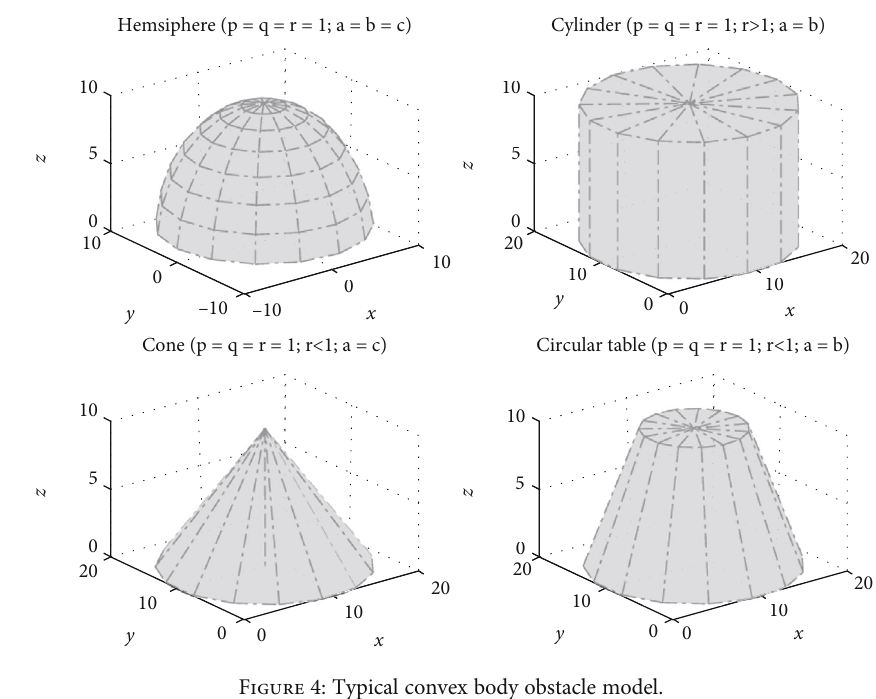
Figure 4: Typical convex body obstacle